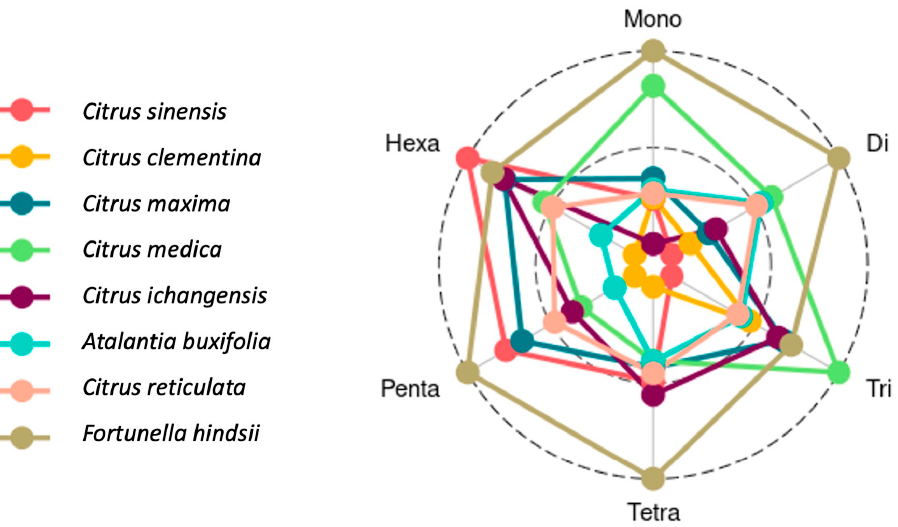
Figure 3. Distribution of motif types in the predicted SSR